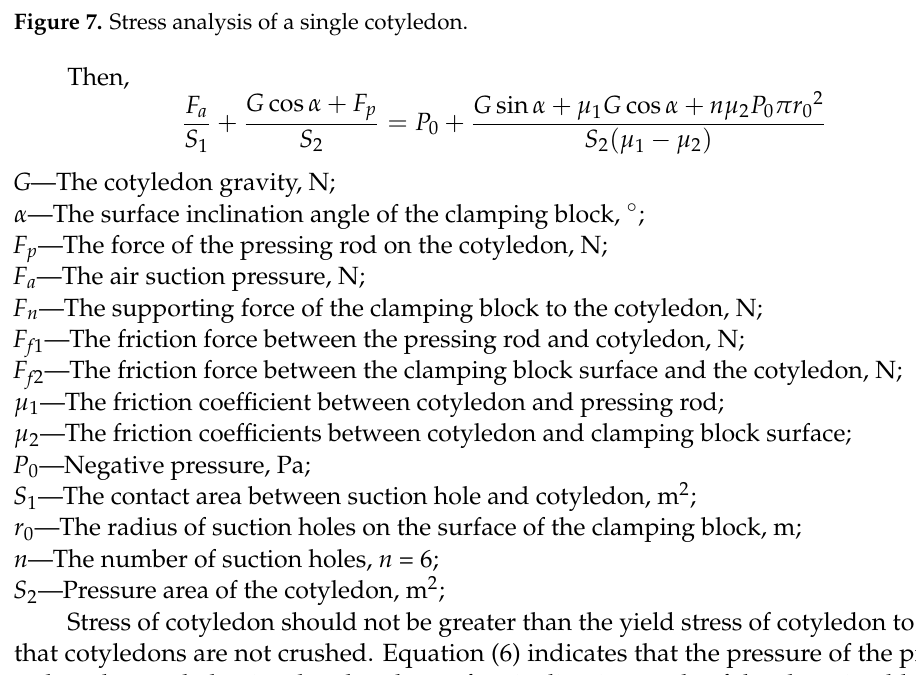
Figure 7. Stress analysis of a single cotyledon.